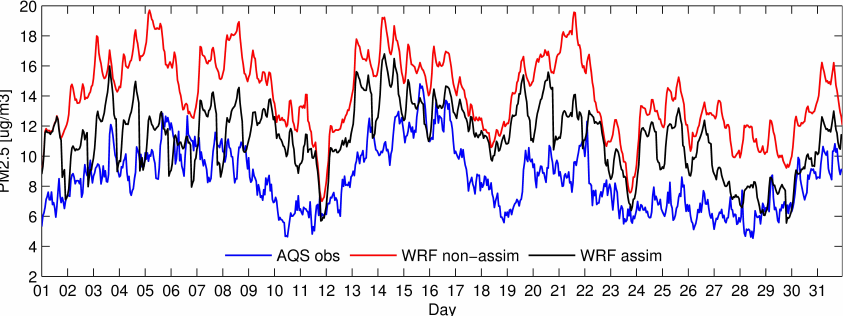
Fig. 3. Model and observed mean PM 2 . 5 time series for May 2010 over AQS sites in California and Nevada. Model simulations are the non-assimilated and assimilated using the NASA NNR